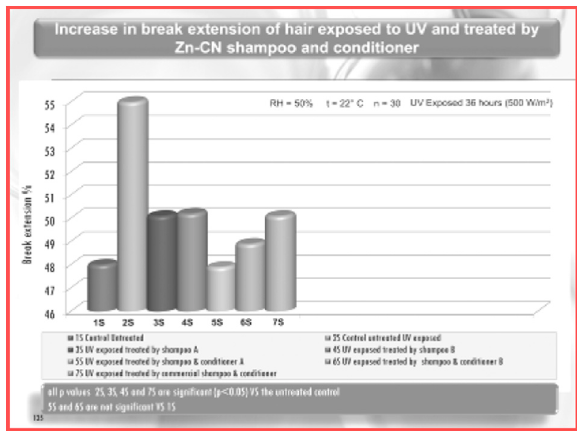
Figure 16. Activity of chitin nanofibril–lignin for hair treatment [77].